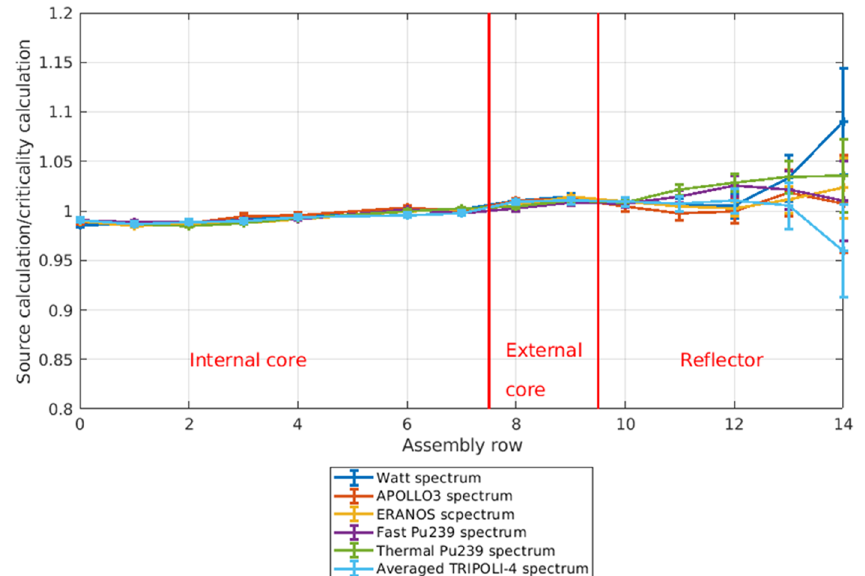
Fig. 10. Radial fl ux comparison between shielding calculations using different fi ssion spectra and the criticality